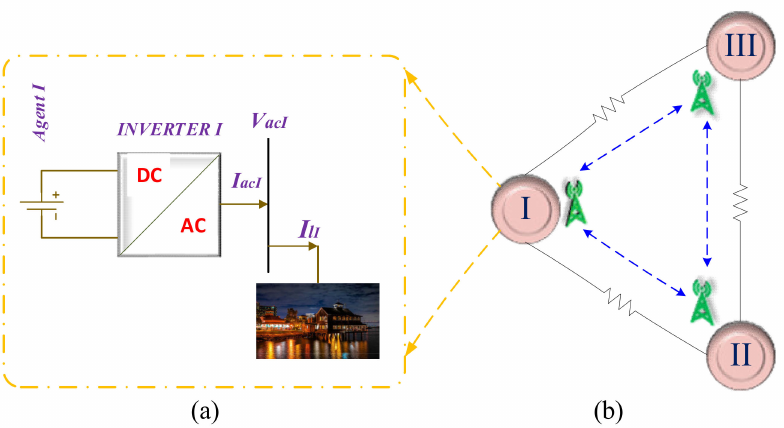
Figure 4. Studied system: ( a ) Unit sample; ( b ) Cyber-physical AC-ISMG with 3 units.